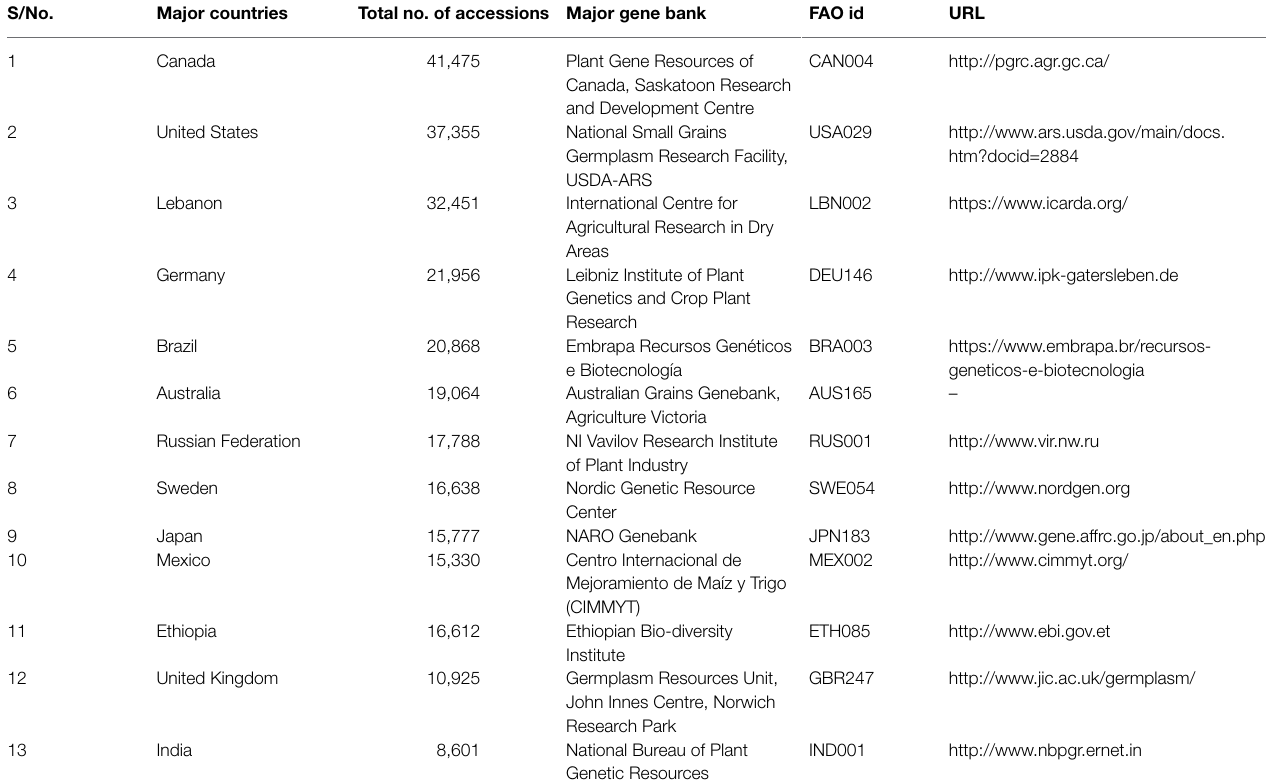
TABLE 1 | Barley accessions present in major gene banks (FAO WIEWS, 2022; Genesys, 2022).